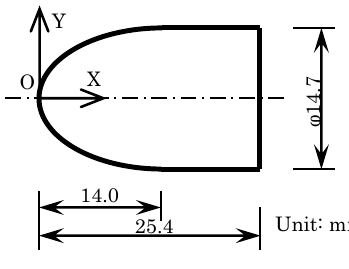
Figure 1. Shape of test model.